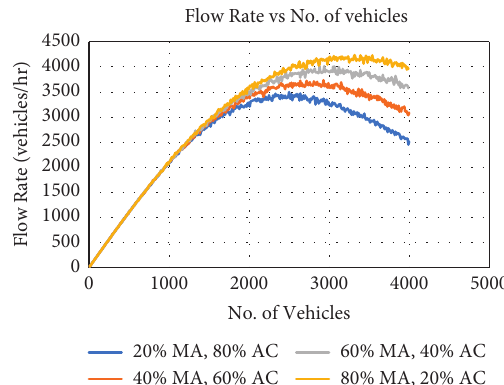
Figure 26: Flow rate vs. no. of vehicles fundamental diagrams for different compositions of MA and AC.